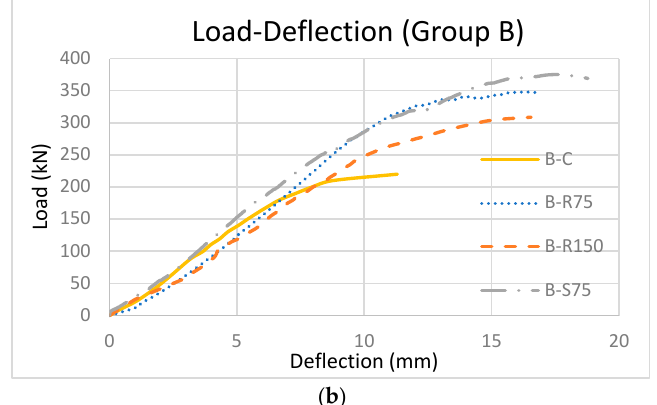
Figure 7. Experimental load–deflection curves for: ( a ) group A; ( b ) group B.